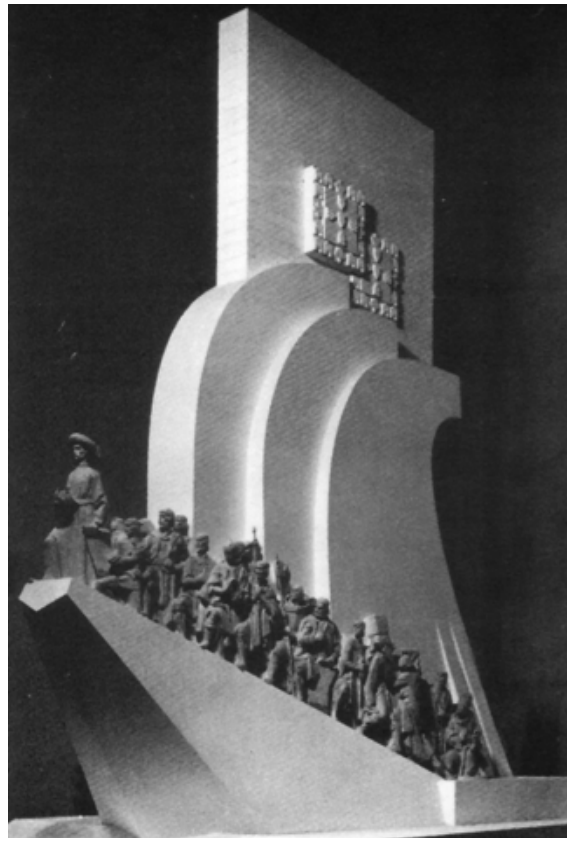
FIGURE 6 | C. Telmo, L. Almeida, L. Barros, Monument to Dis- coveries, 1939,